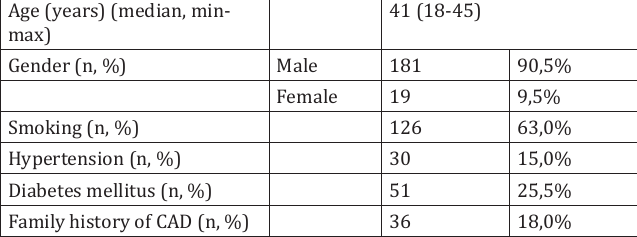
Clinical characteristics of the study population